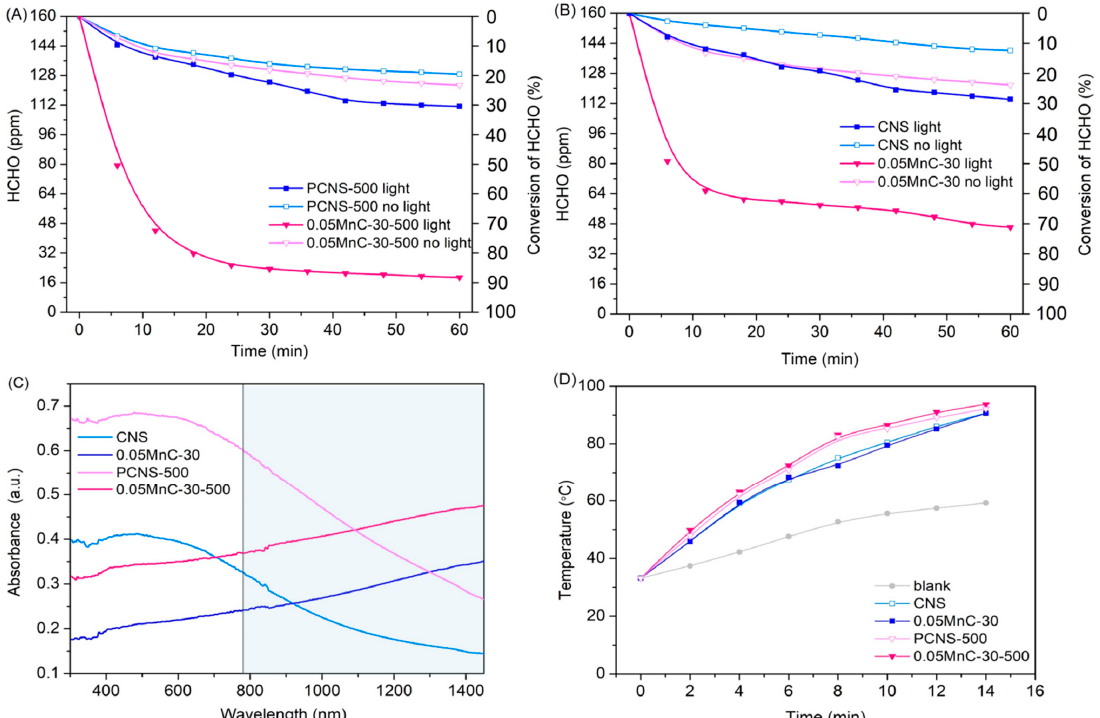
Figure 4. ( A ) Catalytic performance of PCNS and Mn − PCNS for HCHO elimination with and with ‐ out irradiation. ( B ) Catalytic performance of CNS and Mn − CNS for HCHO elimination with and irradiation. ( B ) Catalytic performance of CNS and Mn-CNS for HCHO elimination with and without without irradiation; ( C )UV − Vis − NIR DRS pro fi les of CNS, 0.05MnC − 30, PCNS − 500, and irradiation; ( C )UV-Vis-NIR DRS profiles of CNS, 0.05MnC-30, PCNS-500, and 0.05MnC-30-500. 0.05MnC − 30 − 500. ( D ) Change in surface temperature of catalysts under visible light irradiation. ( D ) Change in surface temperature of catalysts under visible light